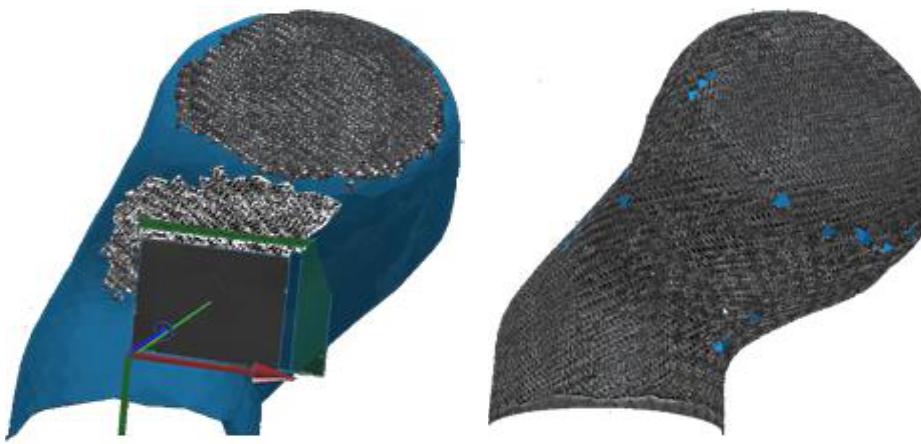
Figure 6. Capturing and mapping of surface images onto the structural surface mesh.